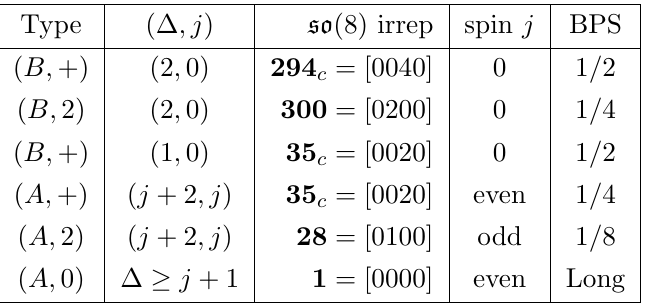
Table 1 . The possible superconformal multiplets in the S (cid:2) S OPE. The so (3 ; 2) (cid:8) so (8) quantum numbers are those of the superconformal primary in each